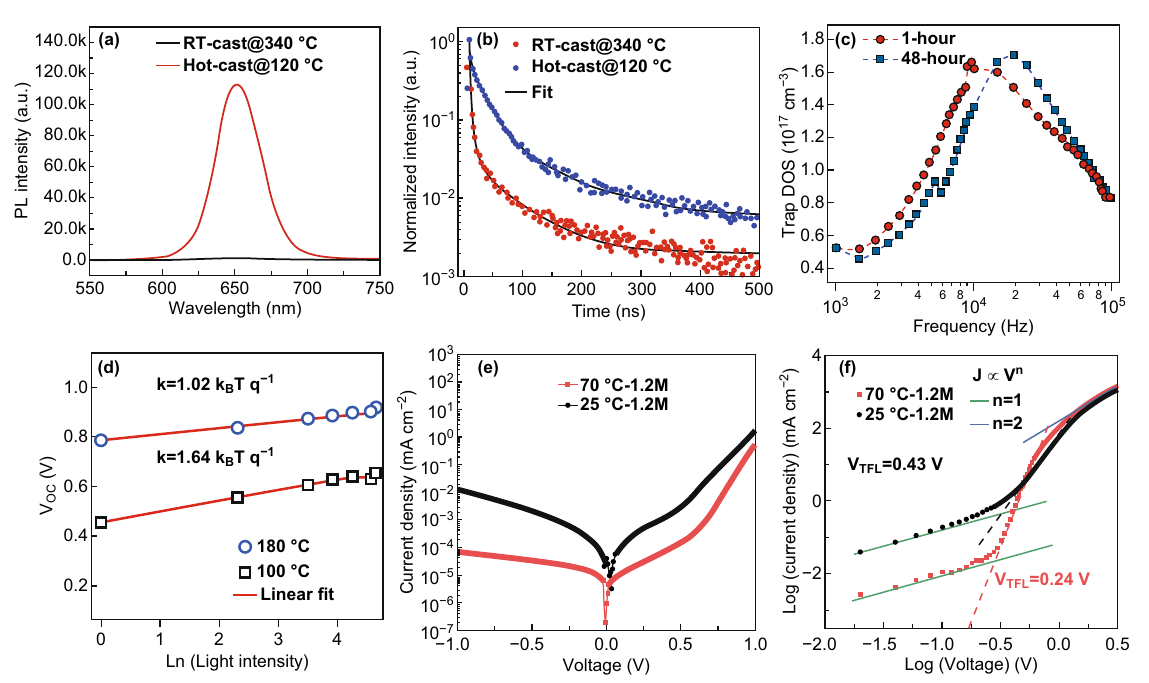
Fig. 6 a , b PL and TRPL spectra of CsPbI 2 Br films fabricated using RT and hot casting [88]. Copyright © 2019 The Royal Society of Chemis- try. c Trap density of states for the device with 1-h and 48-h aged perovskite precursors [46]. Copyright © 2017 WILEY-VCH Verlag GmbH & Co. KGaA, Weinheim. d V oc as a function of illumination light intensity for a large-grain device (180 °C) and a small-grain device (100 °C) [19]. Copyright © 2017 American Association for the Advancement of Science. e J – V characteristics of PSCs swept from 1.0 to − 1.0 V in the dark. f J – V characteristics of hole-only devices [53]. Copyright © 2016 WILEY-VCH Verlag GmbH & Co. KGaA,